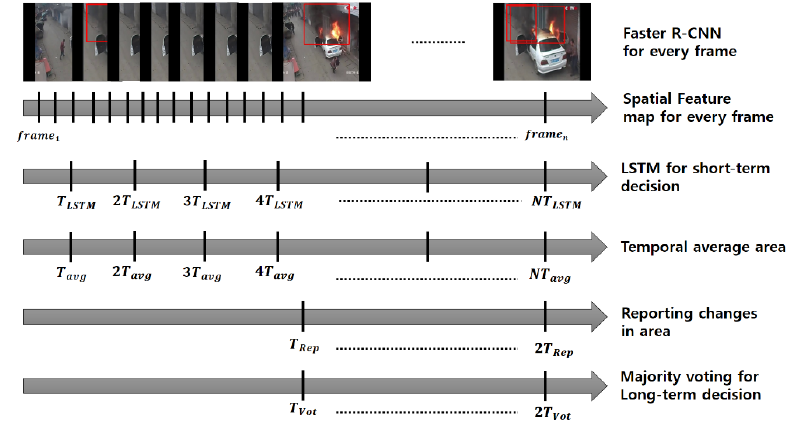
Figure 2. Timing diagram of fire detection.